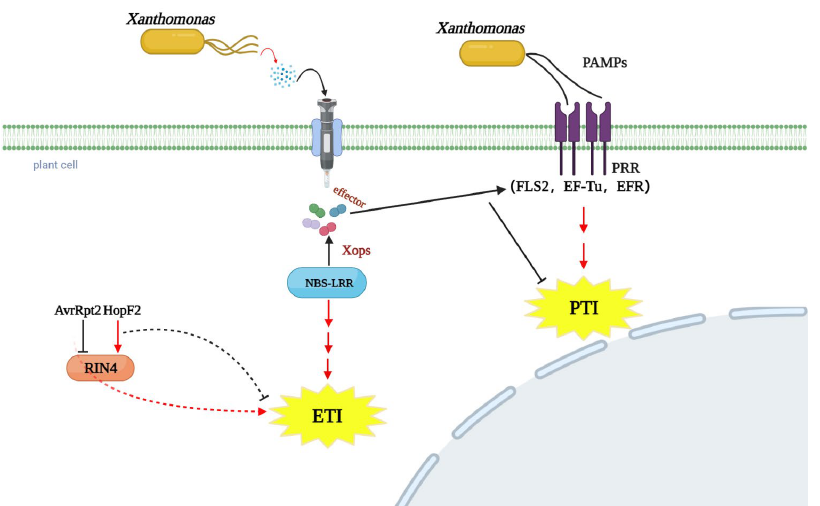
Figure 3. Xanthomonas uses the type III secretion system (T3SS) to secrete effectors into host plant cells. When Xanthomonas infects plants, the plant surface pathogen recognition receptor (PRR) triggers the PTI response. In response to further infection by pathogens, plants evolved a nucleotide-binding site leucine-rich recombinant protein (NBS-LRR) to recognize the Xops effector. When the effectors are recognized, the plant second line of defense ETI immune response is activated and the plant HR response is